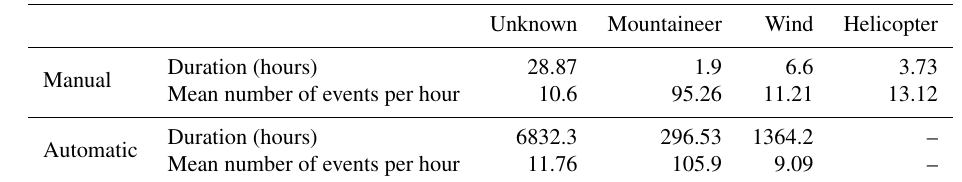
Table 4. Statistics of the manually and automatically annotated sets of 2017 per annotation category. “Unknown” represents the category when none of the other categories could have been identified. Given are the total duration of annotated segments per category and the mean number of STA/LTA events per category.